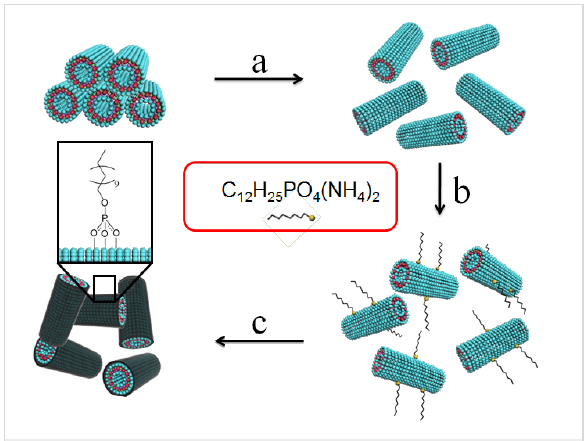
Figure 4: Schematic illustration of dodecylphosphate chemisorbing onto the surface of individually dispersed imogolite nanotubes: (a) Dispersion of freeze-dried imogolite powder into weak acidic water by electrostatic repulsion; (b) chemisorption of dodecylphosphate onto the outer surface of individually dispersed imogolite nanotubes; (c) puri- fying the product and solidifying it by freeze-drying. Reprinted with permission from W. Ma et al. , Chem. Lett. 2011, 40, 159–161 [33]. © 2011, The Chemical Society of